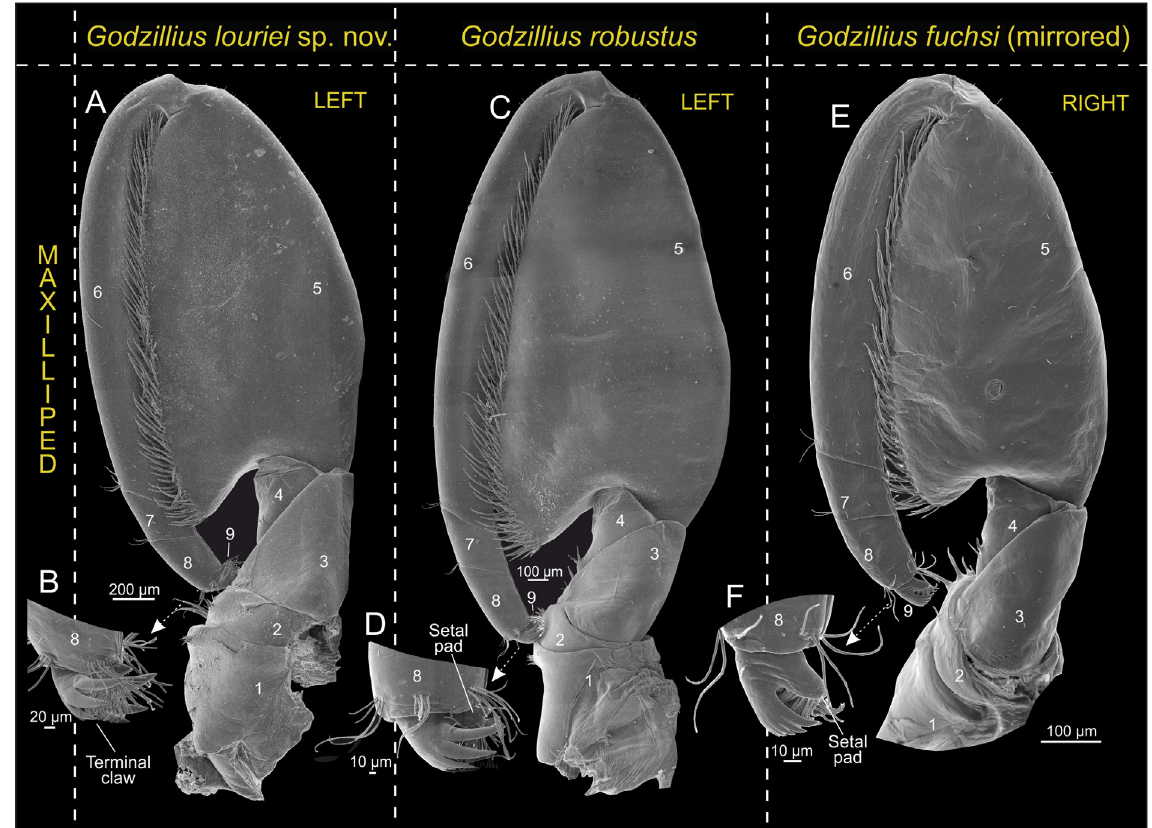
Fig. 10. Morphological comparison of maxilliped (mxp) between Godzillius louriei sp. nov.